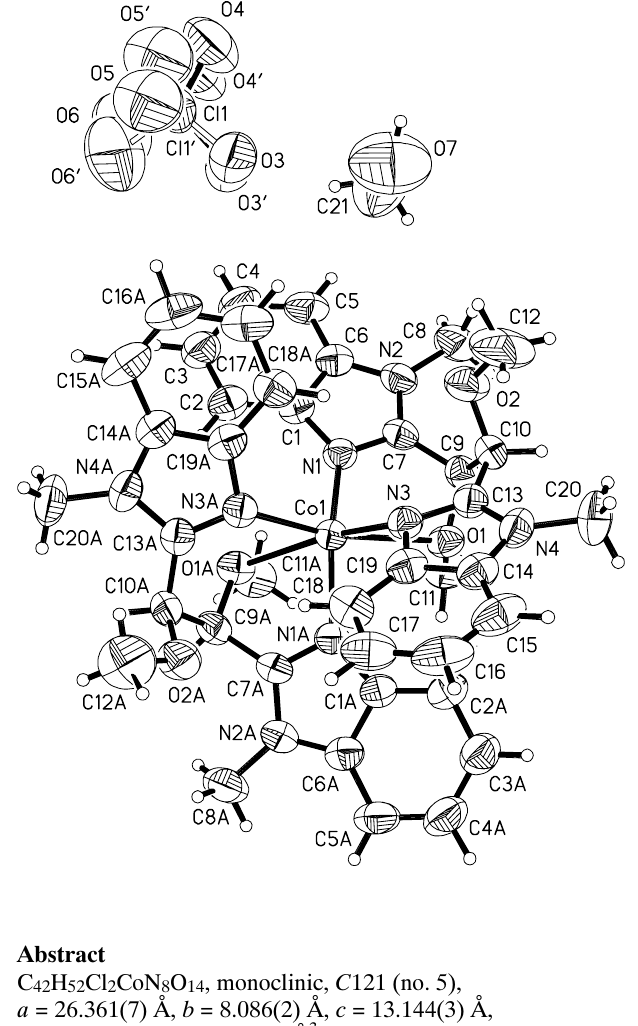
Table 1. Data collection and